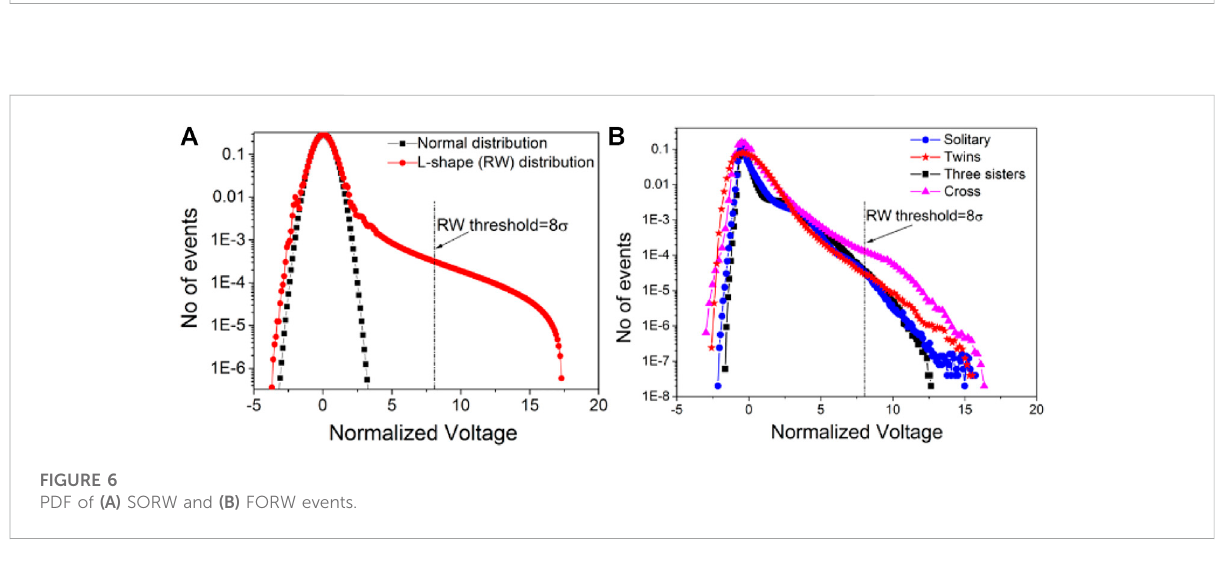
FIGURE 6 PDF of (A) SORW and (B) FORW events.